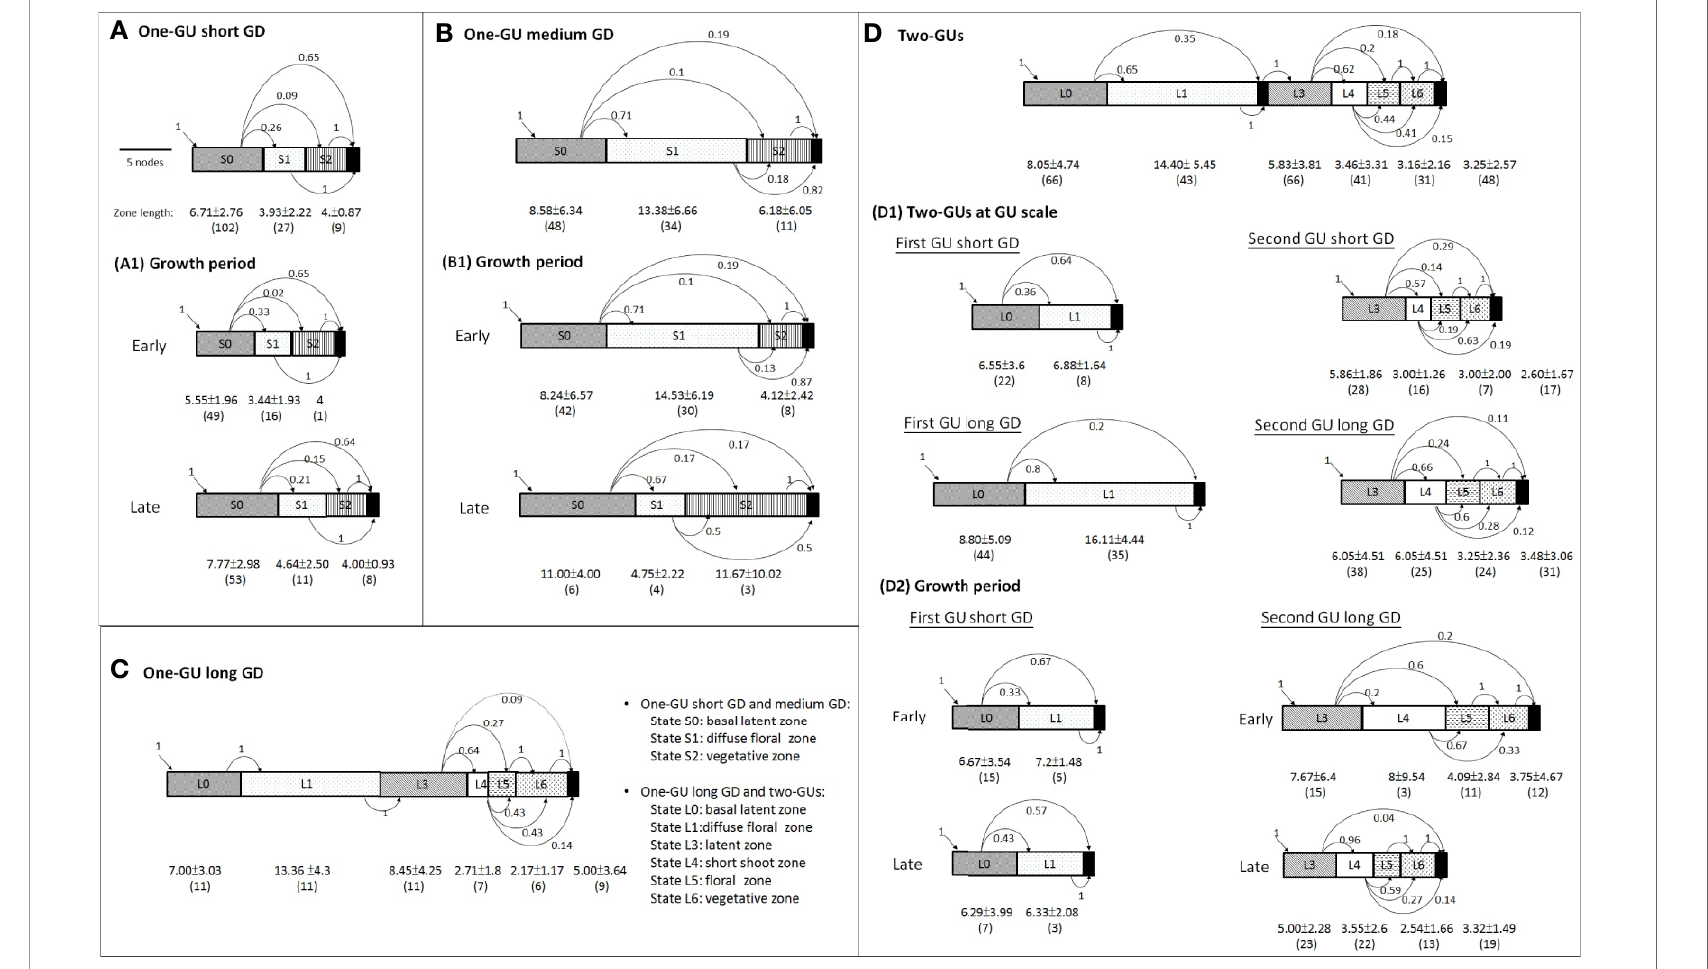
FIGURE 5 | Schematic representation of branching patterns in four shoot categories (A – D) , subgroups of two-GU shoots (D1), and subgroups of the growth period (A1, B1, D2). The successive zones of the shoots are represented by rectangles. The number in the middle of the rectangles indicates the state numbers, as de fi ned in the corresponding general model. The black rectangles at the right represent the absorbing end states while those located between states 1 and 3 in the two-GU shoots represent the growth cessation during a growing season. The transitions between states are indicated by arrows, with the associated probabilities indicated nearby. The number of zone (in brackets) and zone lengths for the number of metamers are indicated below each